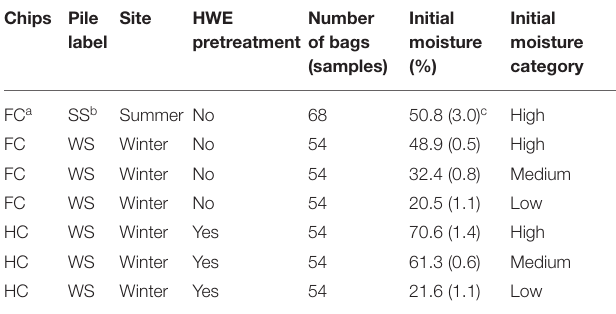
TABLE 3 | Initial moisture content of freshly harvested and hot water extracted (HWE) willow chips that were inserted into storage piles in the summer (SS) with leaf material and in the winter (WS) when no leaves were